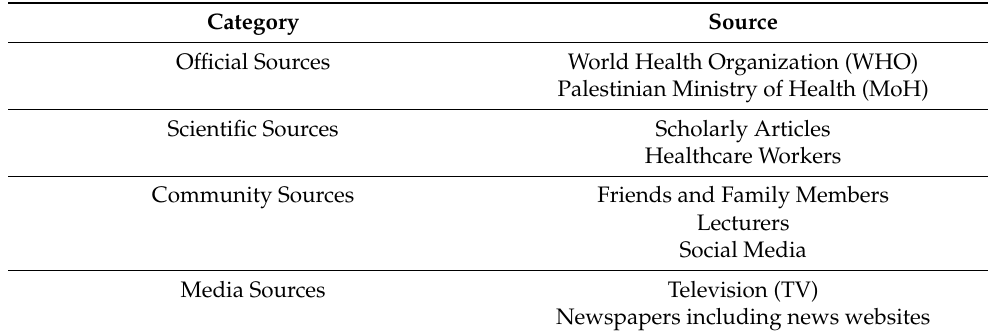
Table 1. Information sources used by Palestinian students during the COVID-19 outbreak, May